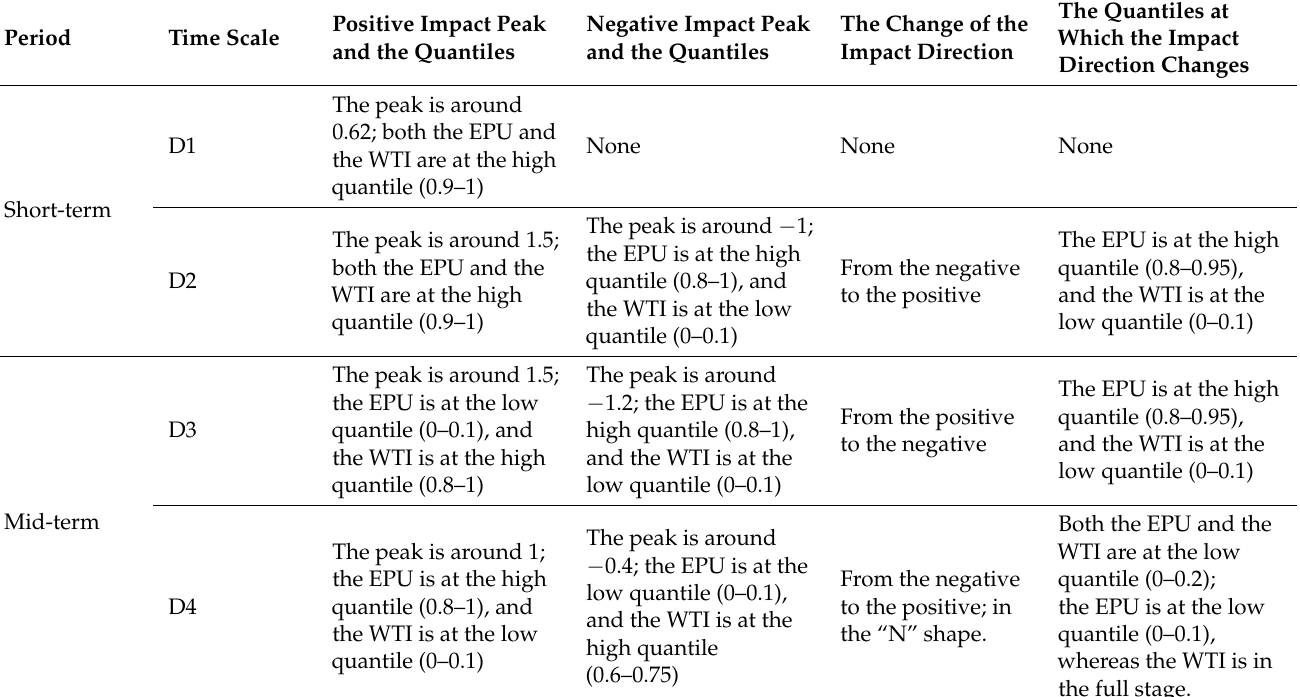
Table 3. Comparison of the impact characteristics of the EPU on the WTI at different time